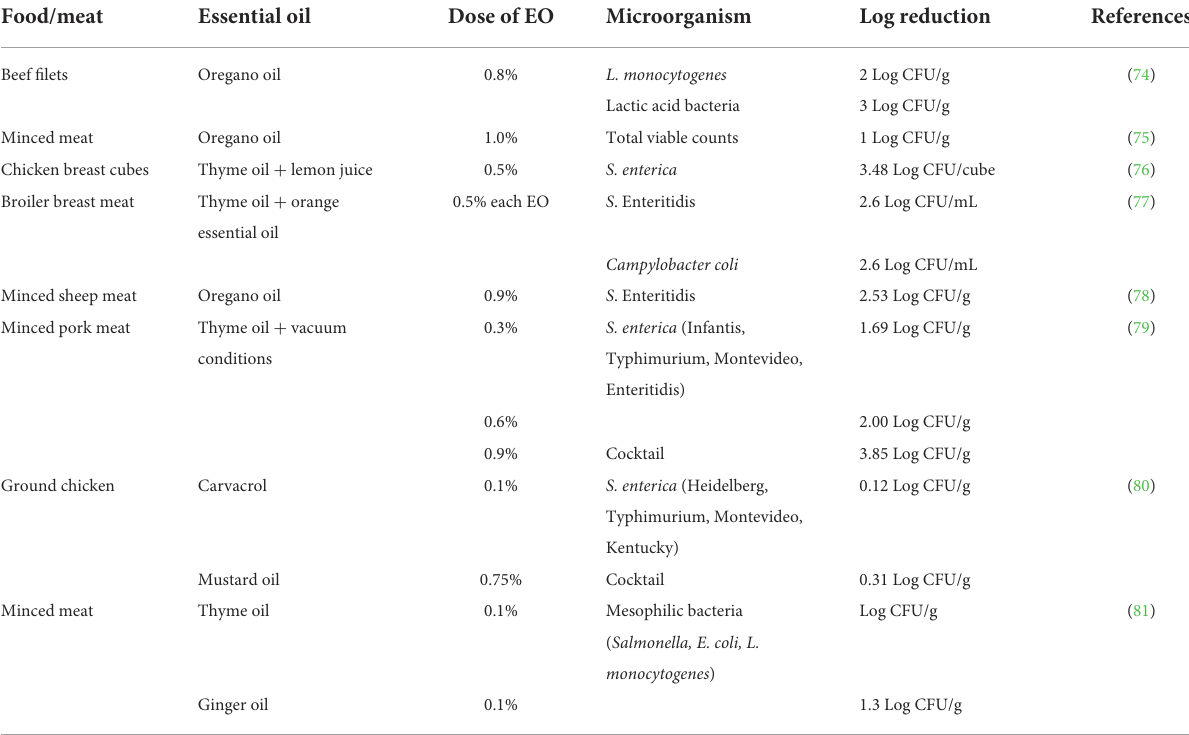
TABLE 2 Summary of antimicrobial efficacy for essential oils at various doses used to control spoilage and pathogenic bacteria in meat and poultry